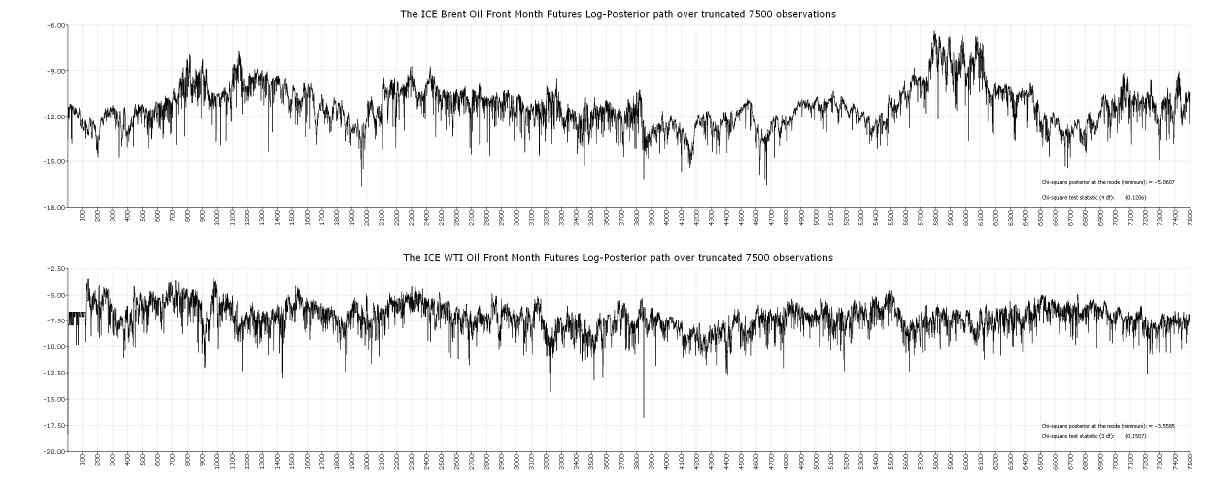
Figure 2. MCMC Posterior Chain from 250 k Optimal Stochastic Volatility Model ( R = 75.000) .